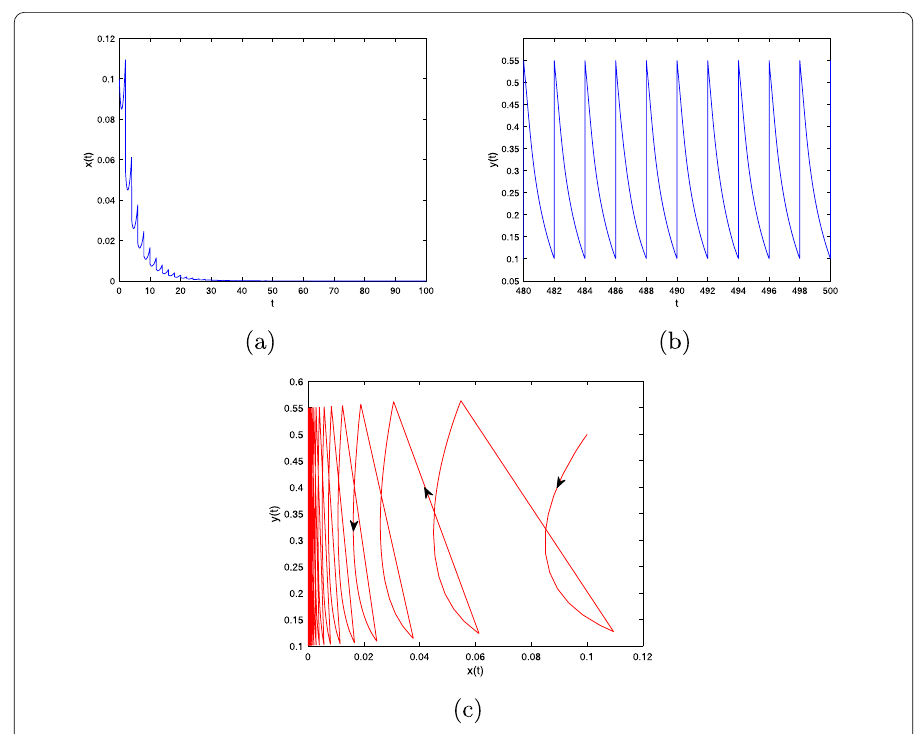
Figure 2 The numerical simulation of the impulsive system in Eq. (7) tends toward the periodically oscillatory solution (0, ˜ y ( t )) using r = 0.8, k = 0.5, β = 0.7, a = 0.3, b = 0.05, μ = 0.85, d = 0.85, η = 0.1, p 1 = p 2 = p 3 = 0.5 when ( x (0), y (0)) = (0.1,0.5) and T = 2 < T max = 2.47: ( a ) the time series simulation of the prey density x ( t ) approaching zero as t is sufficiently large; ( b ) the time series simulation of the predator density y ( t ) approaching a positive periodic solution as t is large enough; ( c ) the trajectory simulation plotted on the xy